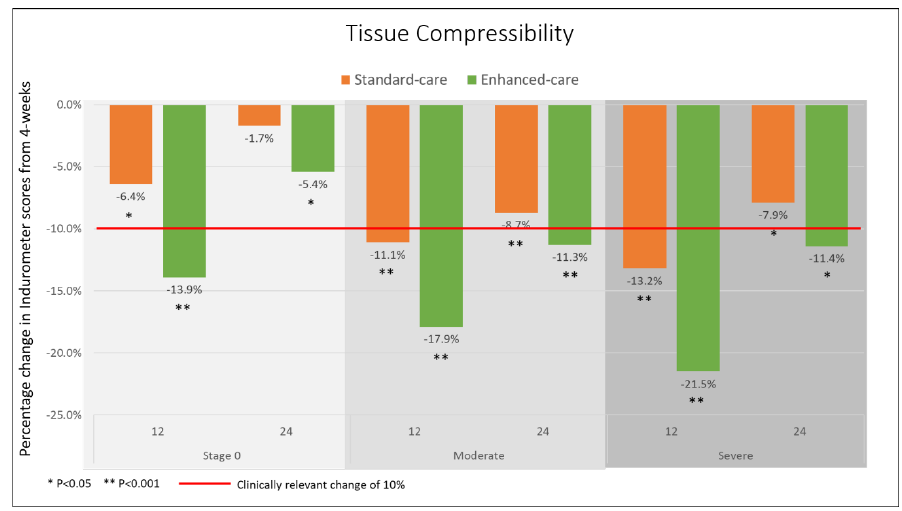
Figure 4. Change in Indurometer scores from baseline (4 weeks) by stage and group.